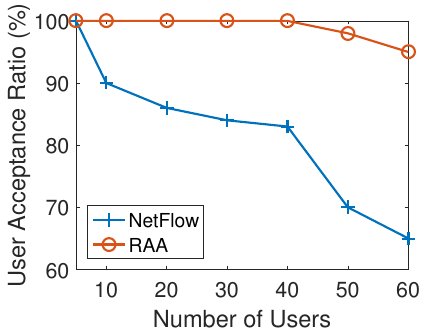
Figure 6. User acceptance ratio for varied numbers of users with 10 APs.